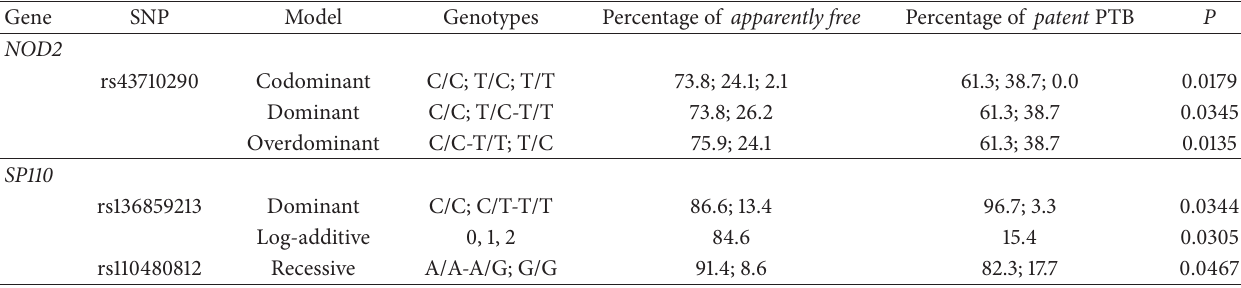
Table 3: Association results from apparently free versus patent PTB logistic regression